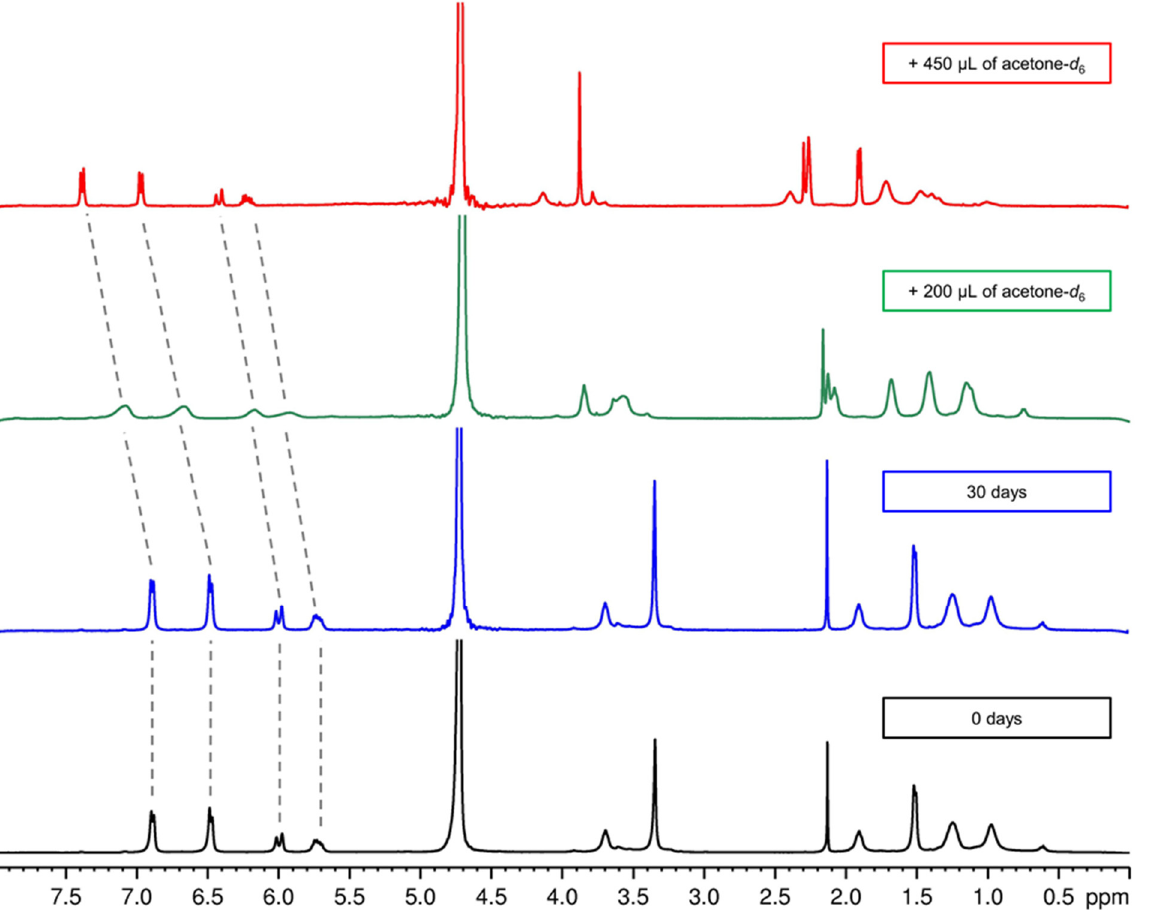
Figure 4. 1 H-NMR of FEO-NC nanosuspension in 450 µL of D 2 O: black line is the freshly prepared sample; blue line is the same sample after 30 days; green line is the sample with the addition of 200 µL of acetone- d 6 ; red line is the sample with the addition of 450 µL of acetone- d 6 .